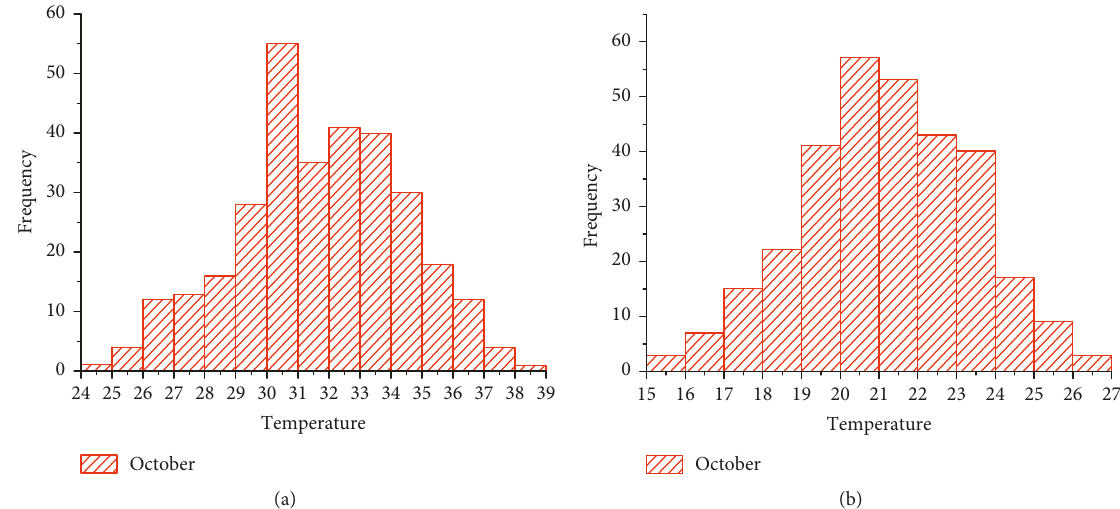
Figure 4: The histogram of the daily extreme value of axial uniform temperature in October. (a) The maximum. (b) The minimum.